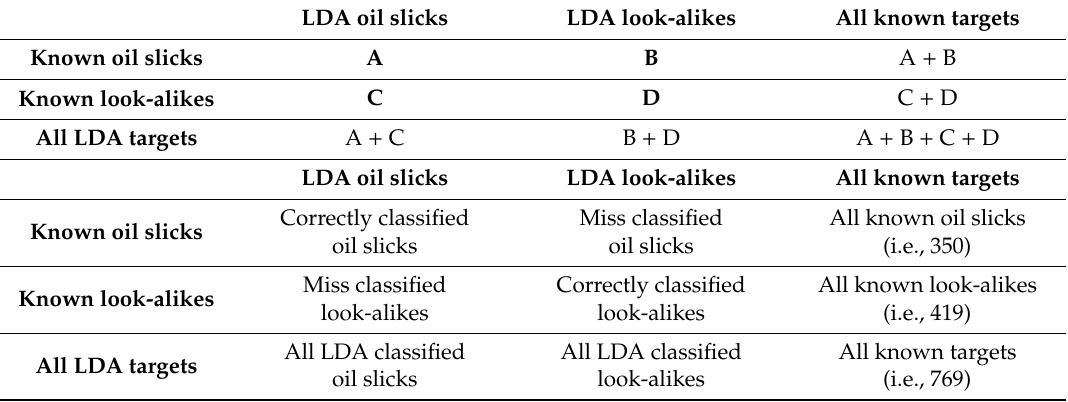
Table 1. Confusion matrix (i.e., two-by-two table: A, B, C, and D) used to evaluate our Linear Discriminant Analyses (LDAs). The overall accuracy is expressed using the diagonal elements: (A + D) / (A + B + C + D).